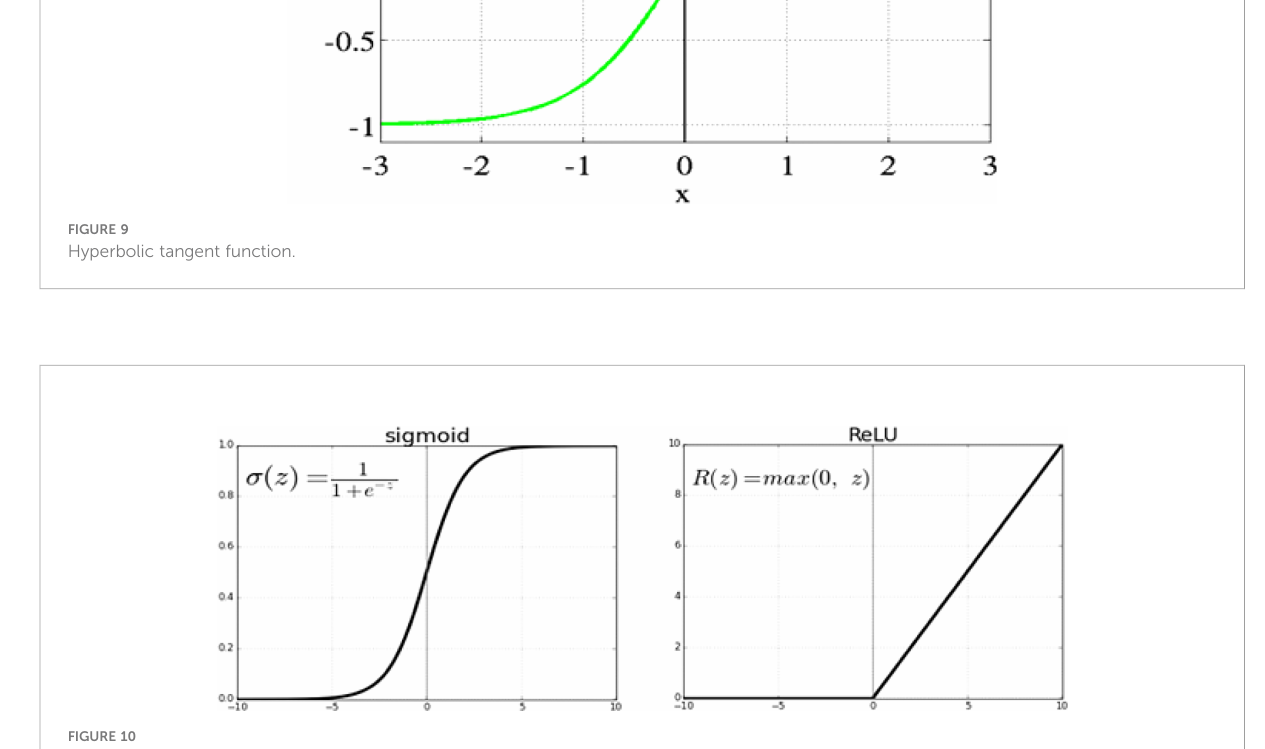
FIGURE 10 ReLU activation function.